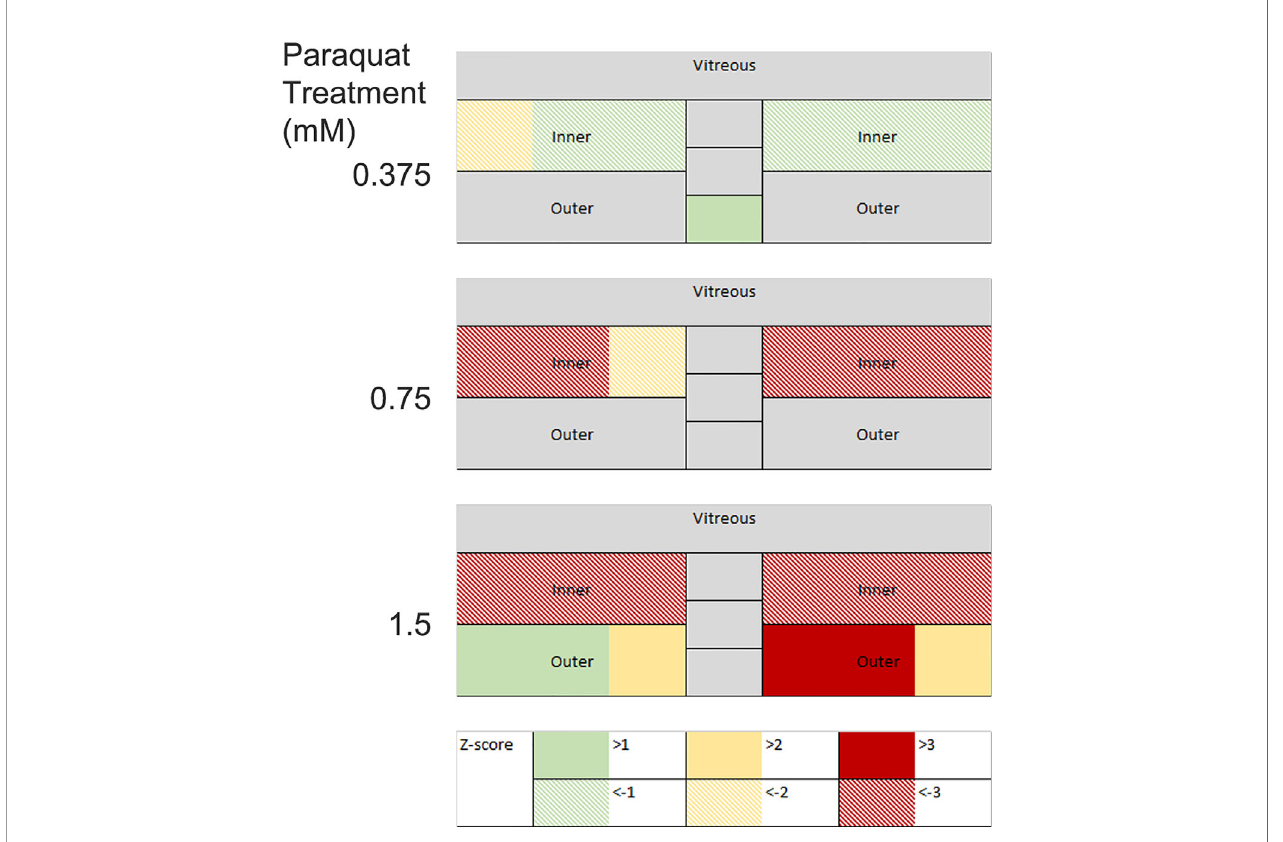
FIGURE 5 | Changes in retinal thickness in mouse eyes following intra-vitreal paraquat instillation were measured on day 10. Images were visualized by OCT, manually segmented, and measured at three points in the temporal, nasal, and optic nerve regions. Measurements are expressed as positive and negative Z-scores relative to a PBS injected control group. Changes in the inner and outer layers are